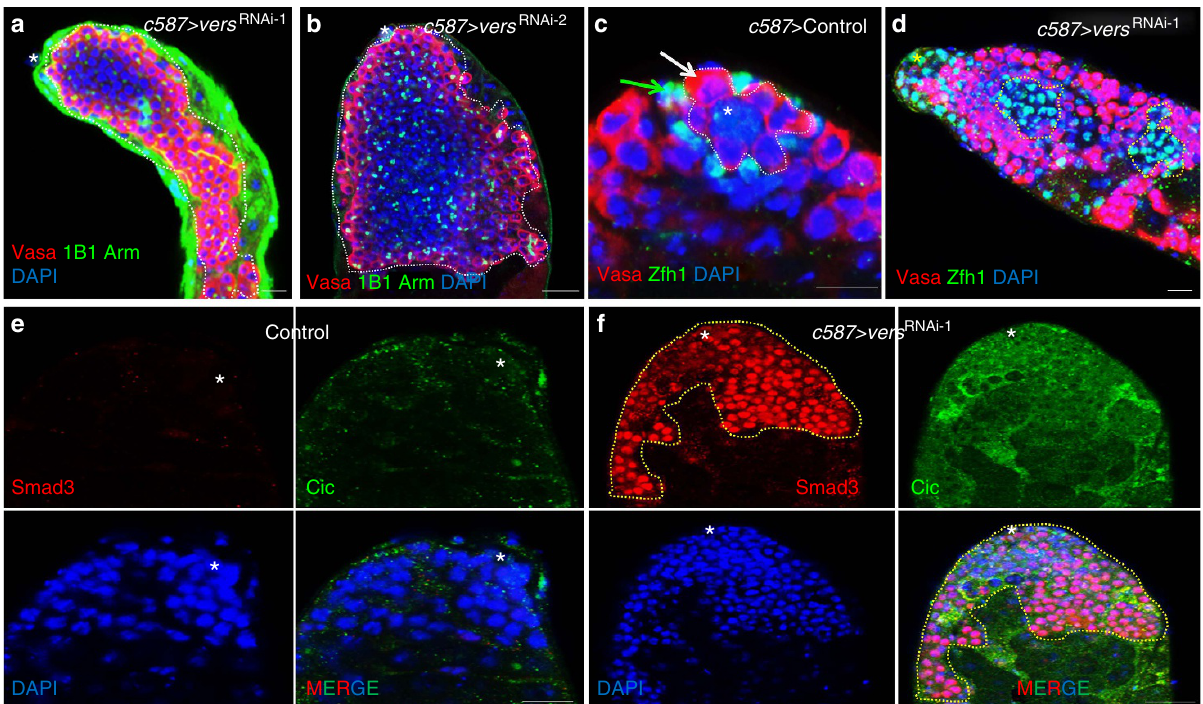
Figure 5 | Vers interacts with EGFR and Dpp to regulate GSC and CySC. ( a , b ) Knockdown of vers in CySC lineage c587-Gal4 ) caused GSC differentiation defects. ( c ) Wild-type (control) testis. ( d ) Knockdown of vers in CySC lineage ( c587-Gal4 ) caused CySC expansion. ( e ) Wild-type (control) testis. ( f ) Knockdown of vers in CySC lineage ( c587-Gal4 ) activates both EGFR and Dpp signalling. Testes of the indicated flies were dissected, stained with antibodies to Vasa (red), Arm (green, hub cells at the apex) and 1B1 (green, marks round spectrosomes and branched fusomes) in a , b , Vasa (red) and Zfh1 (green, marks CySCs) in c , d , Smad3 (red) and Cic (green) in e , f , and DAPI (blue, marks the nuclei), and analysed by confocal microscopy. White dotted lines in a , b indicate GSC-like cells. White arrow near hub cells indicates a GSC and green arrow indicates a CySC ( c ). Yellow dotted lines in f indicate Smad3-positive cells. Asterisks indicate hub cells. The flies were cultured at 29 (cid:2) C for 7 days. Scale bars, 10 m